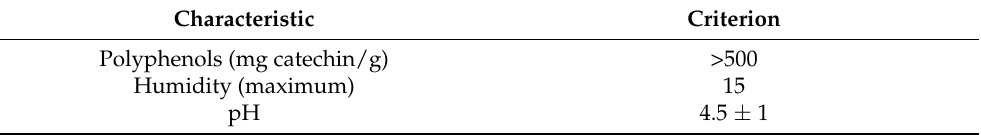
Table 1. Technical specification of MGM-P.